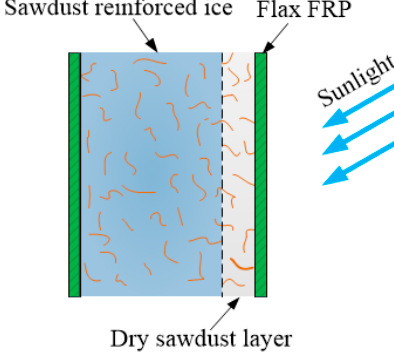
Figure 16. Melting mechanism of sawdust-reinforced ice in SIFFT specimen.